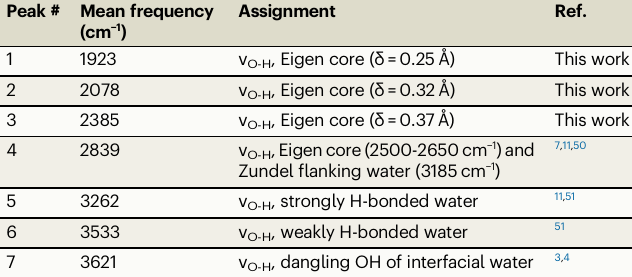
Table 1 | Peak assignments for operando FTIR spectra of Ti 3 C 2 T x MXene in dilute H 2 SO 4 electrolyte